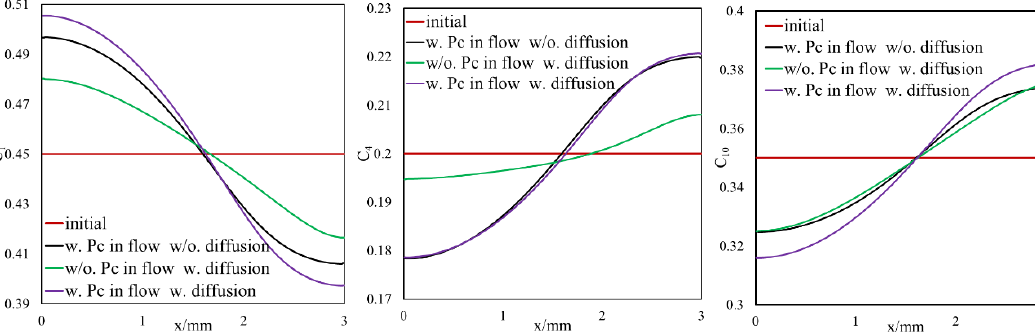
Figure 15. Oil and gas density/viscosity profile, with Pc in flow without diffusion vs. without Pc in flow with diffusion vs. with Pc in flow without diffusion, 100 days, ternary mixture. 3.2. Slim Tube Simulations and MMP We used slim tube simulations (1D fully compositional model) to investigate the influence of molecular diffusion and heterogeneous pore size on MMP for Bakken fluid. Three simulation cases are considered with permeabilities of i.e., 10 μd, 1 μd, and 100 nd. Other reservoir properties are